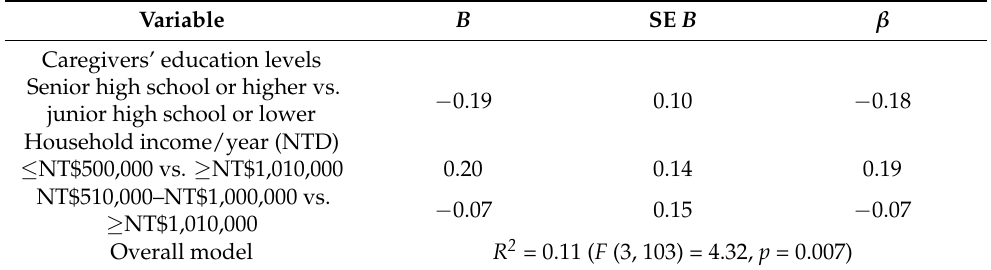
Table 4. Multiple Regression Analysis for Variables Predicting Family Caregiver Burden ( n =